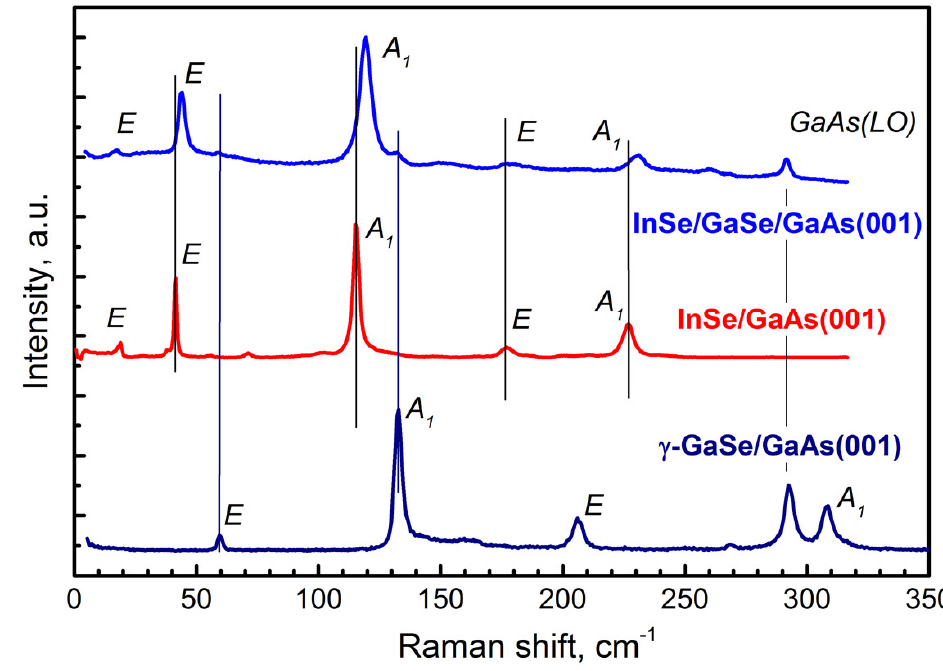
Figure 13. The Raman spectrum (upper curve) of the InSe / GaSe / GaAs(001) structure along with the Raman spectra of both InSe / GaAs(001) (sample # IS1 , middle curve) and γ -GaSe / GaAs(001) (sample # GS1 , lower curve) layers (T = 300 K). The spectra are normalized to the intensity of the A 1 (115 cm − 1 ) phonon line.